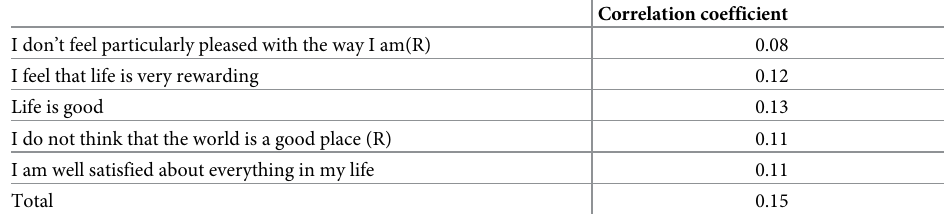
Table 3. Correlation between the oxford happiness questionnaire few items on life satisfaction and self-rated health.